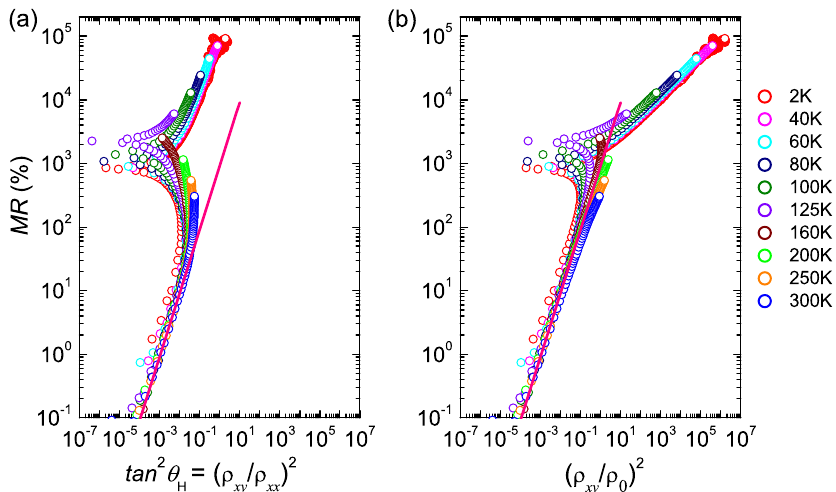
FIG. 4. Alternative scalings for the magnetoresistance in TaP (sample TP1) with Eqs. (3) (a) and (4) (b). The values of ρ are taken from the same dataset as those used for the extended Kohler ’ s rule in Figs. 2(a) – 2(c) and the corresponding ρ Fig. S7(a) [47]. The solid pink lines in (a) and (b), respectively, represent MR ¼ γ same colored open symbols are used in both